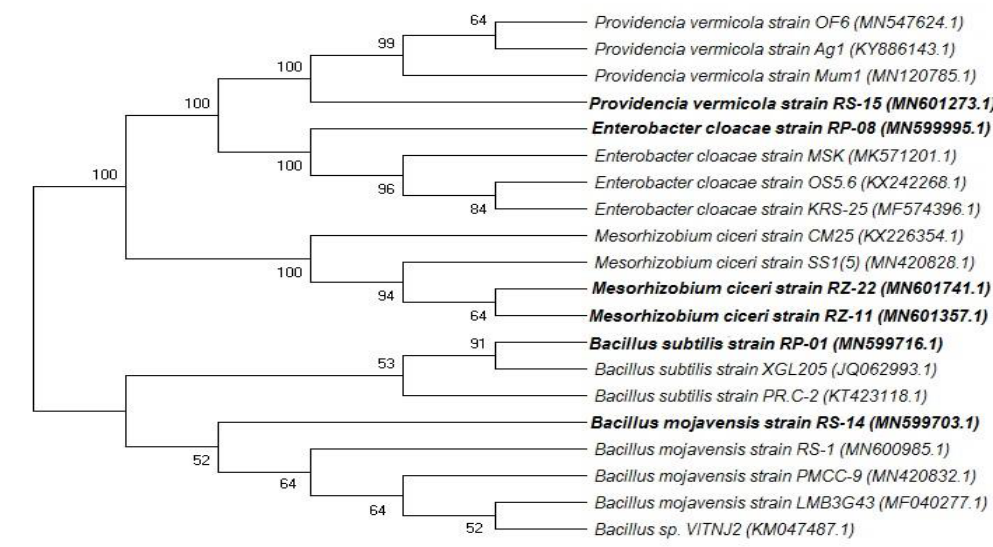
Table 2. Characterization (Biochemical parameters) of most efficient isolated bacterial strains after screening.